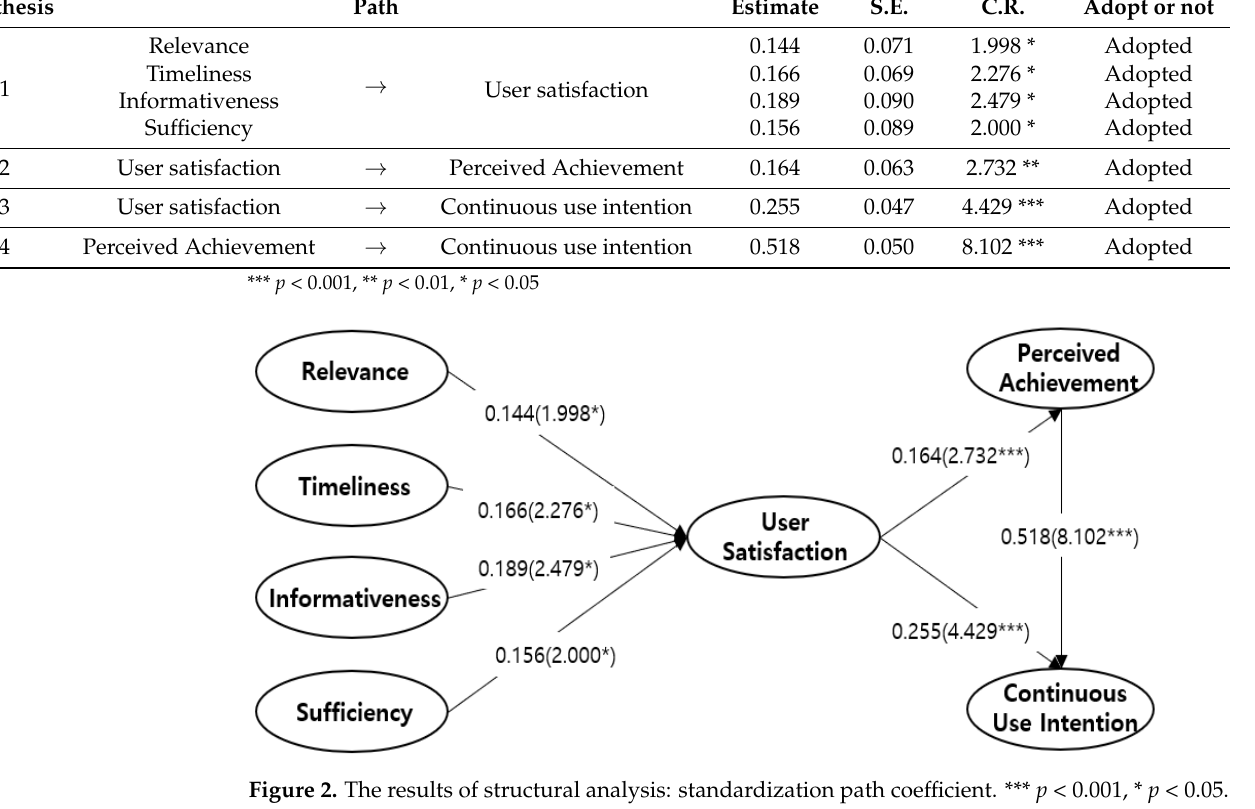
Figure 2. The results of structural analysis: standardization path coefficient.